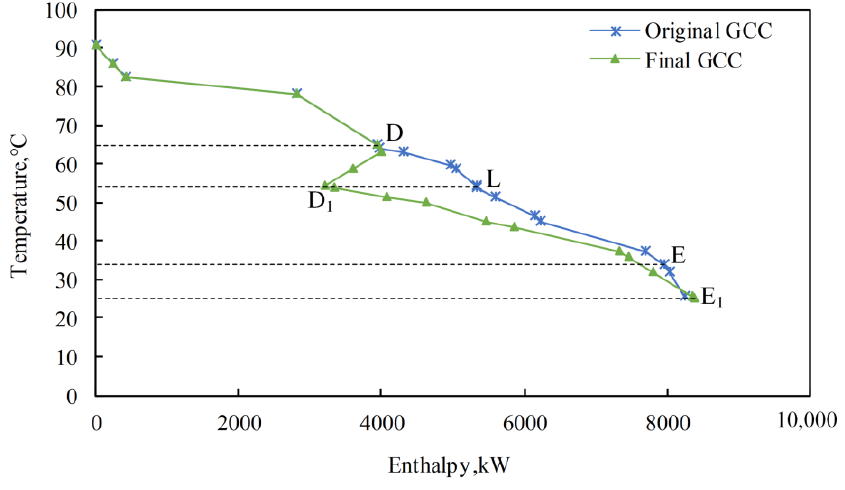
Figure 10. Variation of GCC below the pinch.